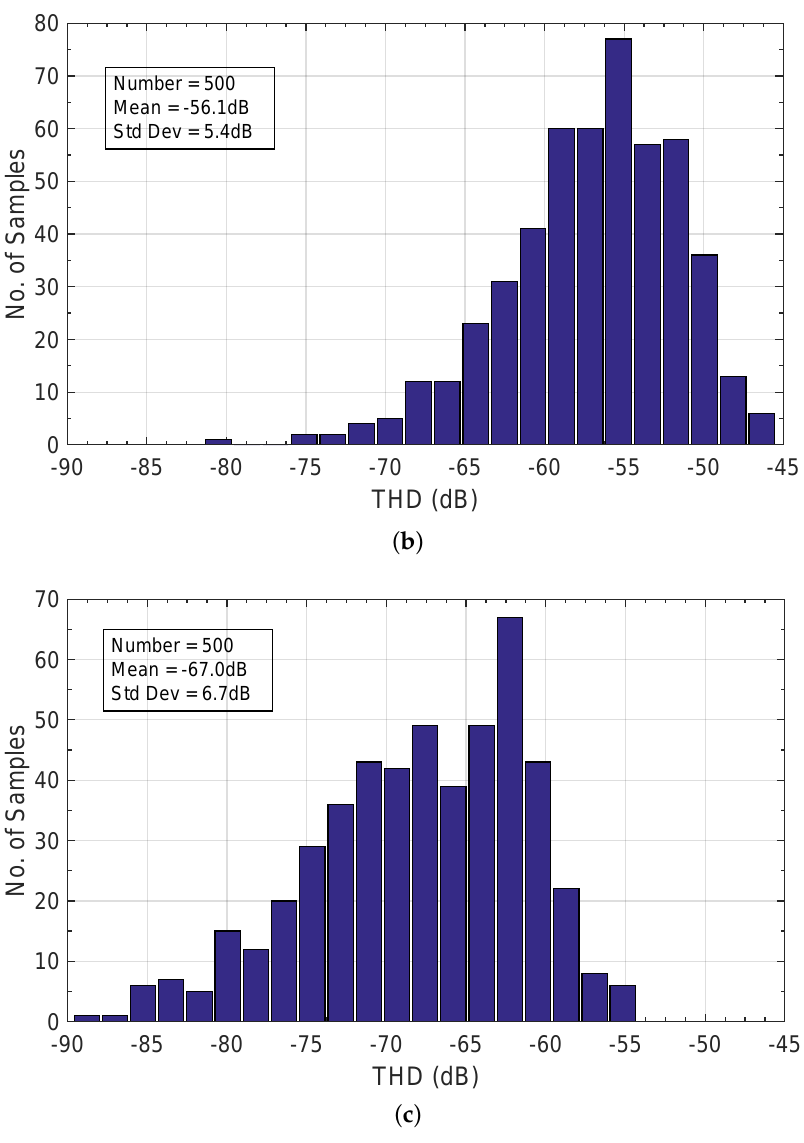
Figure 9. THD@30 µ A pp @1 kHz considering mismatch for ( a ) the CC-CB, ( b ) the QFG-CB and ( c ) the proposed